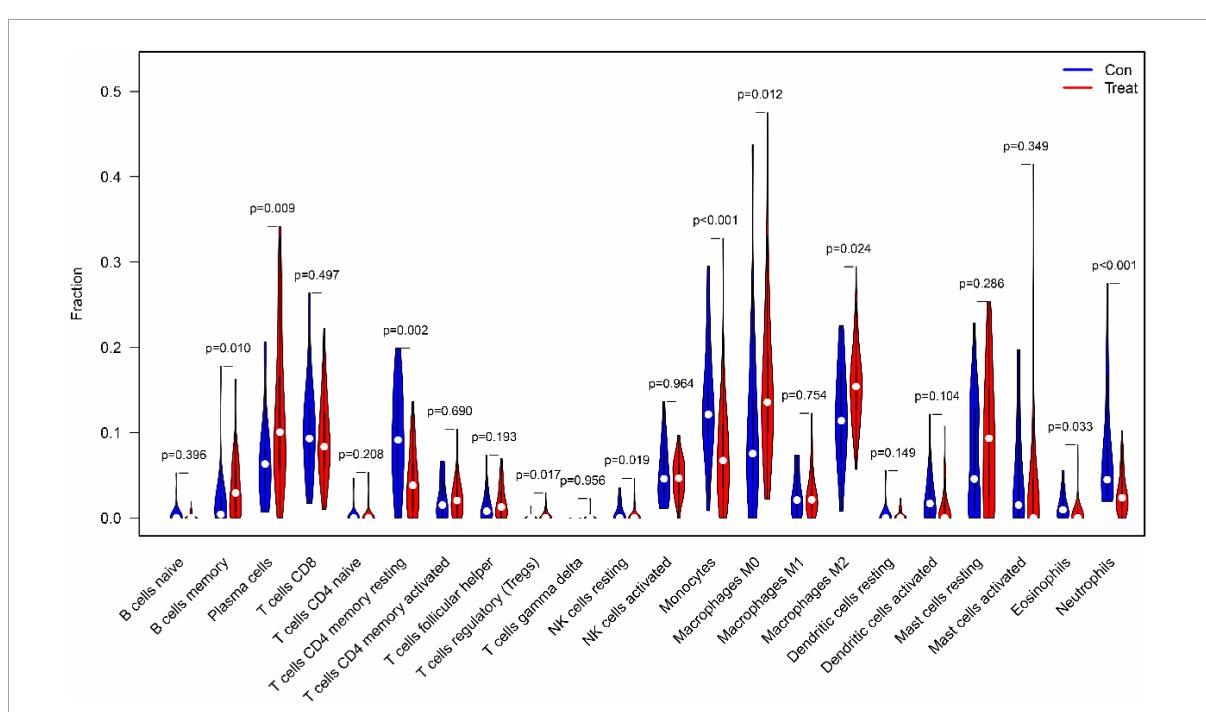
FIGURE12 The comparison of 22 immune cell subtypes of IPF tissue with normal tissue green represents normal samples, and red represents IPF